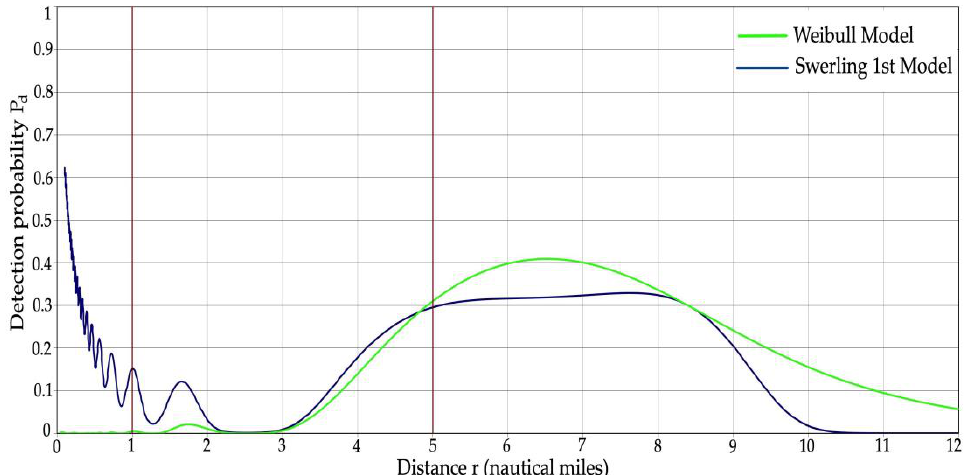
Figure 13. The calculated probability of detecting the Pd of the s/y ALMAK yacht’s reflector by the ARPA radar of the m/f URD vessel during the experiment in the Baltic Sea according to the Weibull model and Swerling 1st model.